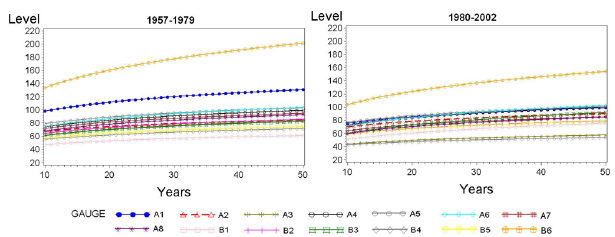
Fig. 6. Expected maximum value of rainfall daily return level (mm) versus number of years return in two consecutive periods (1957– 1979, 1980–2002). Each station is represented by its